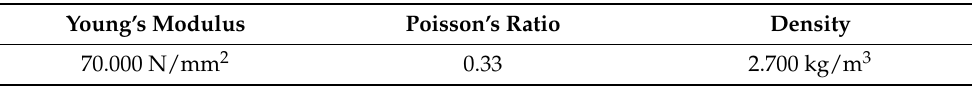
Table 5. The elastic material parameters and the density of the aluminum alloy EN AW-7108